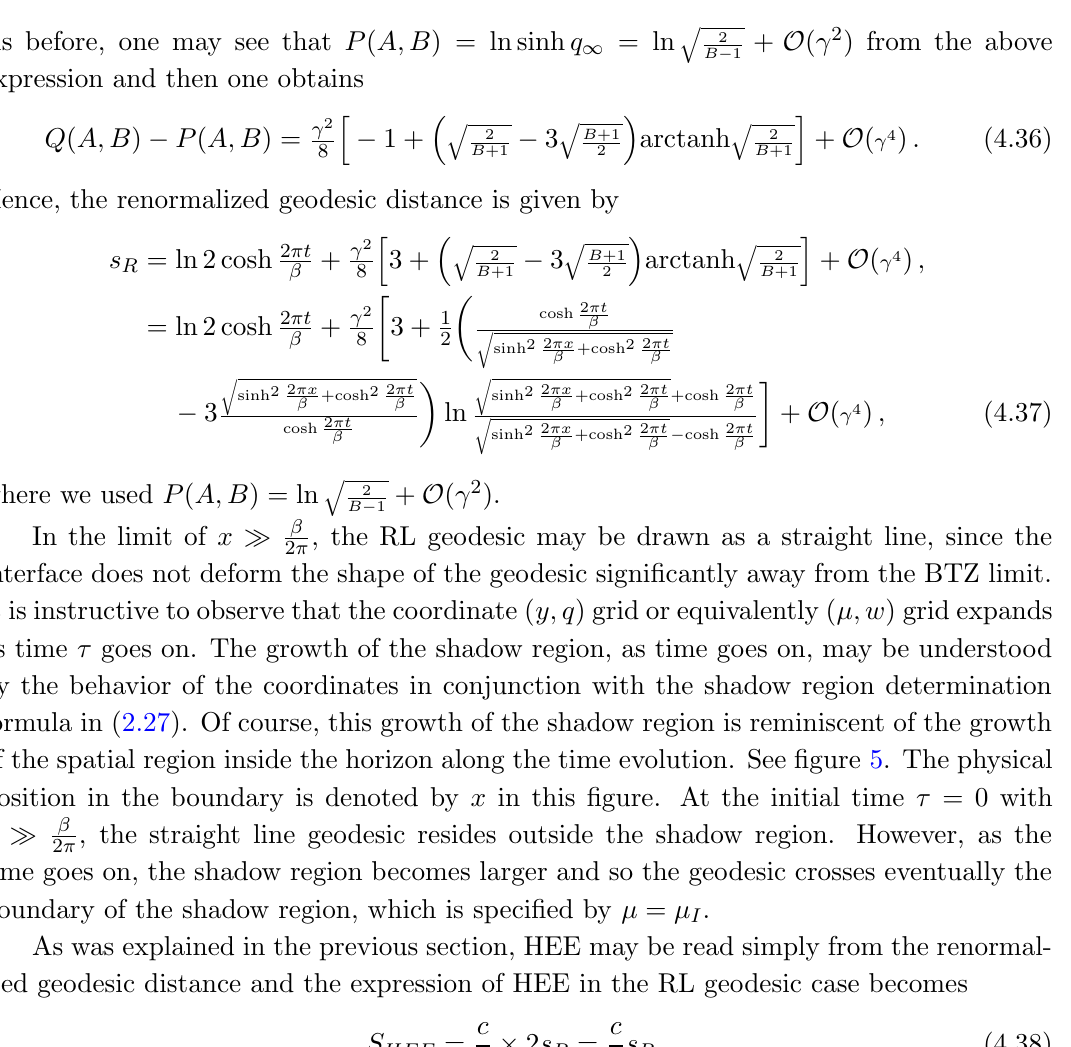
Figure 5 . We have depicted the RL geodesic at (cid:28) = 0 and at a later time (cid:28) > 0 with a shadow region. Though we have depicted a constant (cid:28) slice, the curve (cid:22) = as in (cid:12)gure